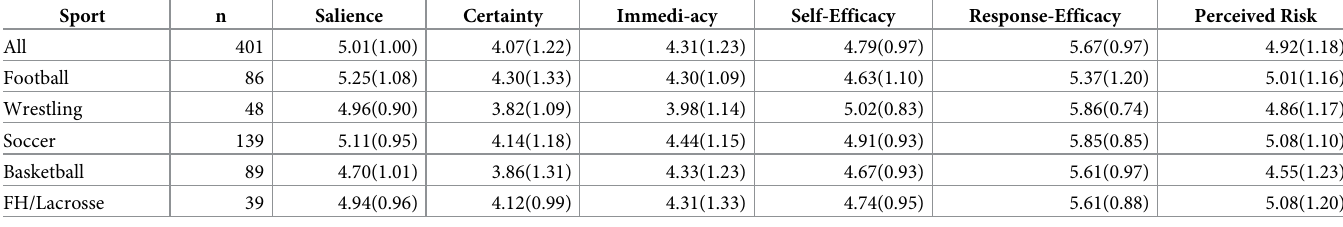
Table 2. Means and standard deviations for vested